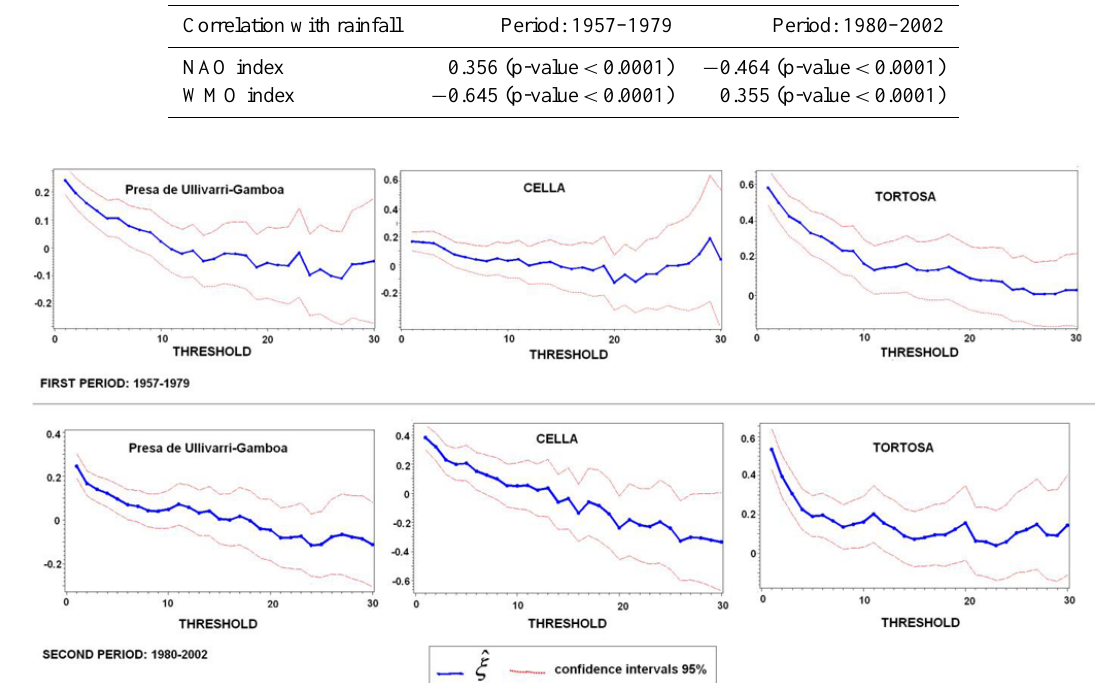
Fig. 4. Plot of estimated GPD parameter ( ξ ) like function of threshold u , at annual scale for the 1957–1979 (top) and 1980–2002 (bottom) periods. Red lines represent the 95% of confidence interval. According to the theory, linearity would be expected from a ˆ u